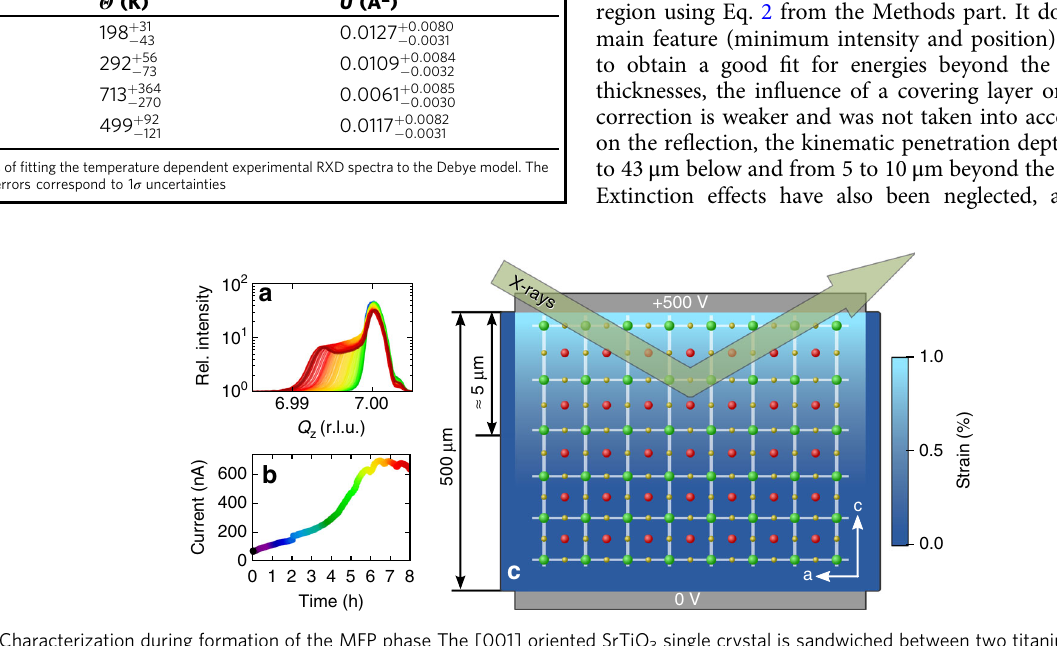
Fig. 3 Characterization during formation of the MFP phase The [001] oriented SrTiO 3 single crystal is sandwiched between two titanium electrodes such that the electric fi eld is directed perpendicular to the surface ( c , not drawn to scale). A few micrometer thick, strained MFP layer can be observed only on the anode side where the X-ray measurements are performed. The diffraction pro fi les ( a , here 007 re fl ection) show a shoulder developing with at lower out of plane momentum transfer Q z (in terms of reciprocal lattice units – r.l.u.) while the leakage current through the crystal ( b )